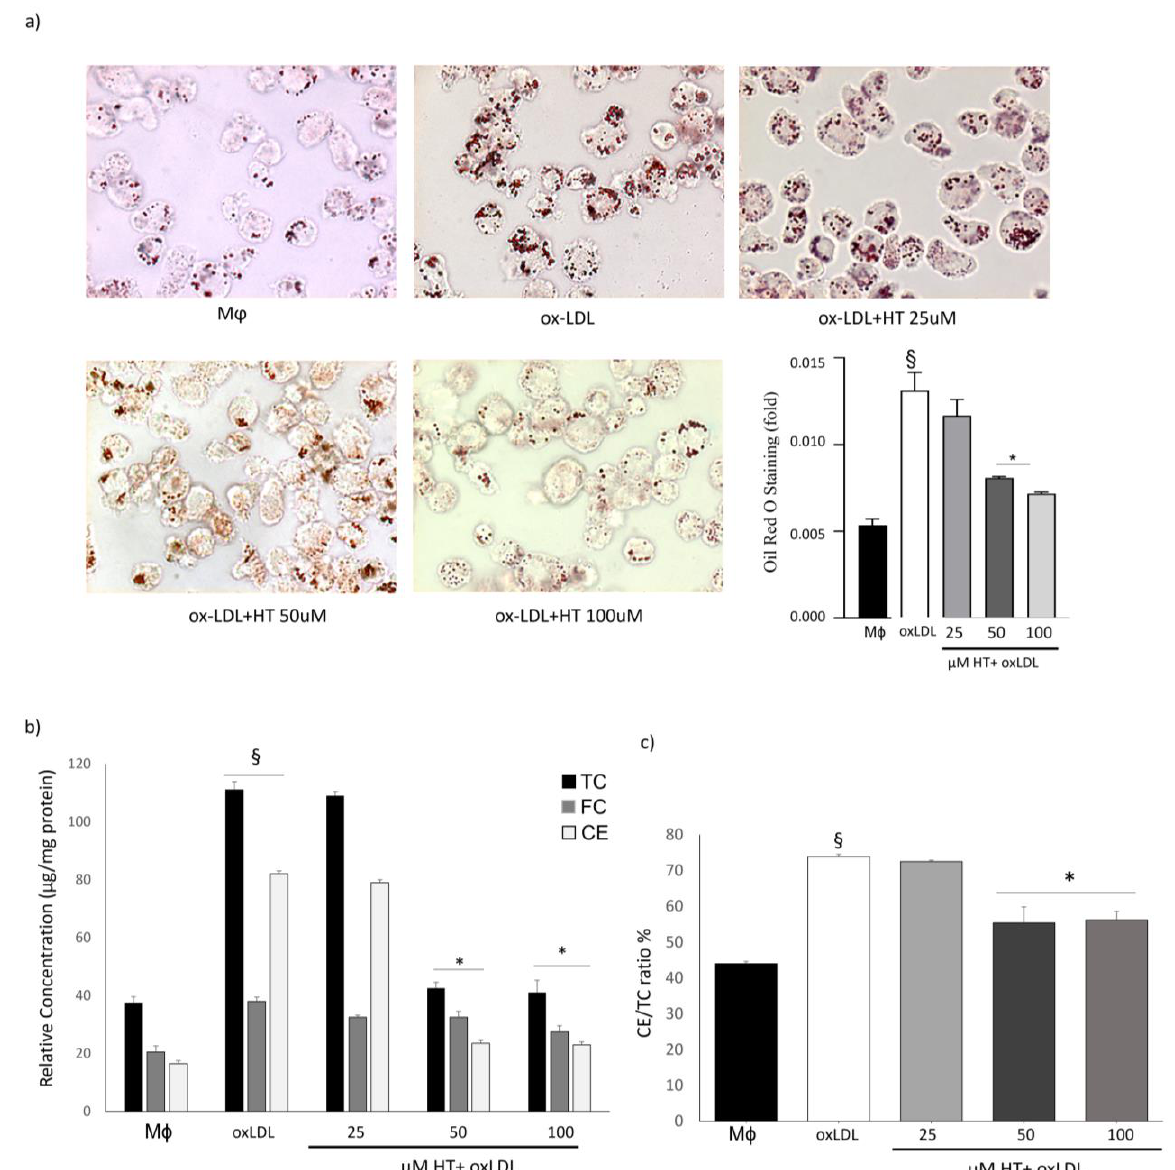
Figure 2. Effects of HT on intracellular lipid accumulation in THP-1 foam cells. ( a ) Foam cells were treated with the indicated concentrations of HT. The cells were stained with Oil Red O (ORO) and evaluated by microscopic (10X magnification) and spectrophotometric analysis. Quantitative assessment of the percentage of lipid accumulation. § p < 0.05 vs. macrophage s (Mϕ) and * p < 0.05 vs. foam cells ( n = 3). ( b ) The content of intracellular TC, FC and CE. ( c ) The ratio of CE to TC. ox-LDL increased the content of TC, FC and CE and the value of CE/TC. HT decreased TC content in foam cells ( n = 3). TC, total cholesterol; FC, free cholesterol; CE, cholesterol ester. §: p < 0.01 vs. Mϕ; * p < 0.05 vs. ox-LDL.